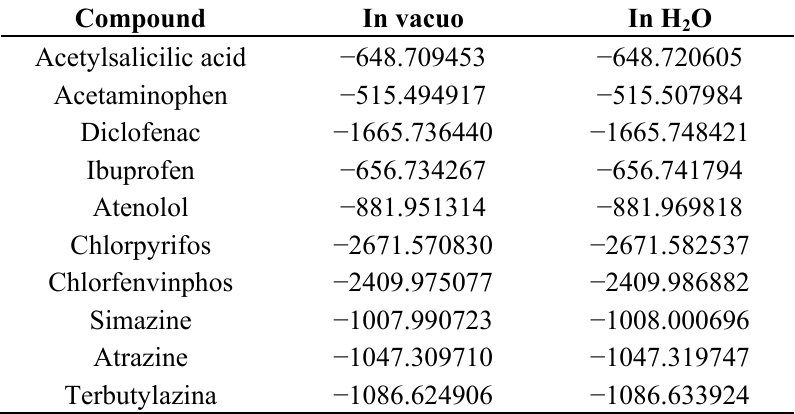
Table 1. B3LYP/6-31G** total energies ( E , au) in vacuo and in water.